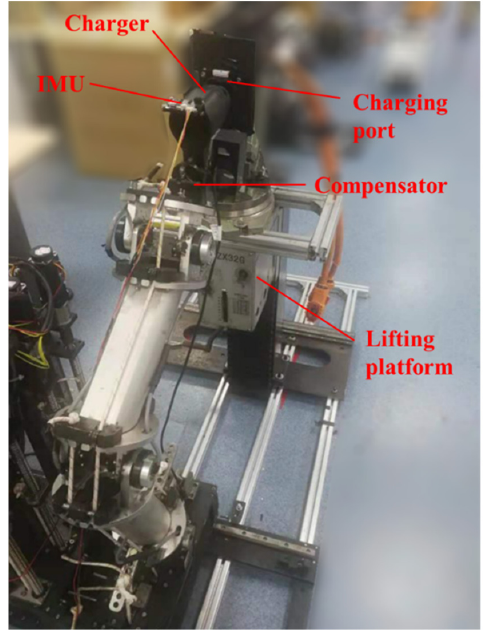
Figure 10. Simulated collision experiment on the serial cable-driven